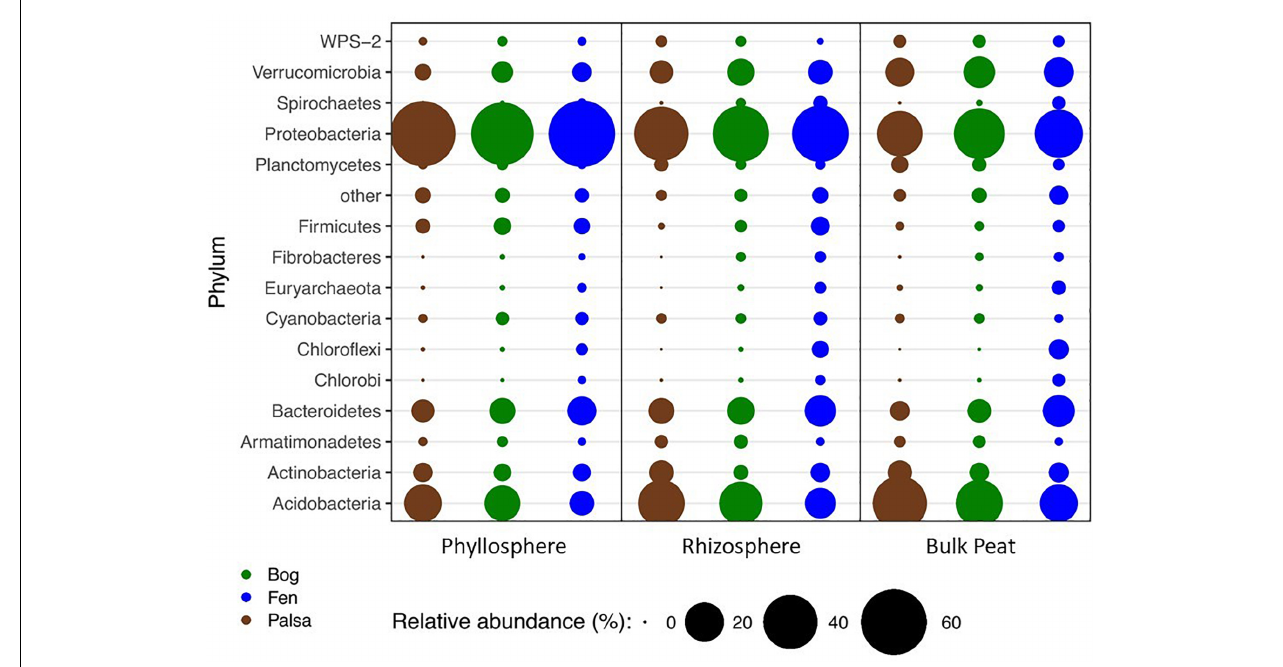
FIGURE 2 | Changes in relative abundance of bacterial phyla across habitats (palsa = brown, bog = green, and fen = blue) and compartments (phyllosphere, rhizosphere, and bulk peat). Circle size corresponds to percent relative